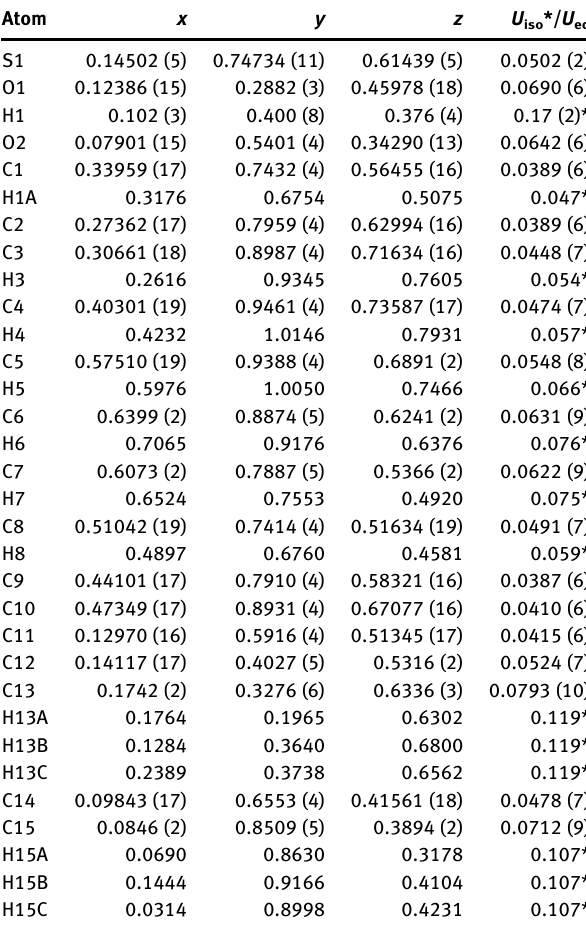
Table  : Fractional atomic coordinates and isotropic or equivalent isotropic displacement parameters (Å 